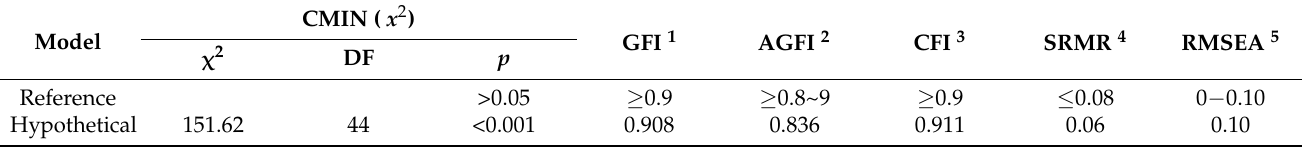
Table 5. Model Fit of the Hypothetical